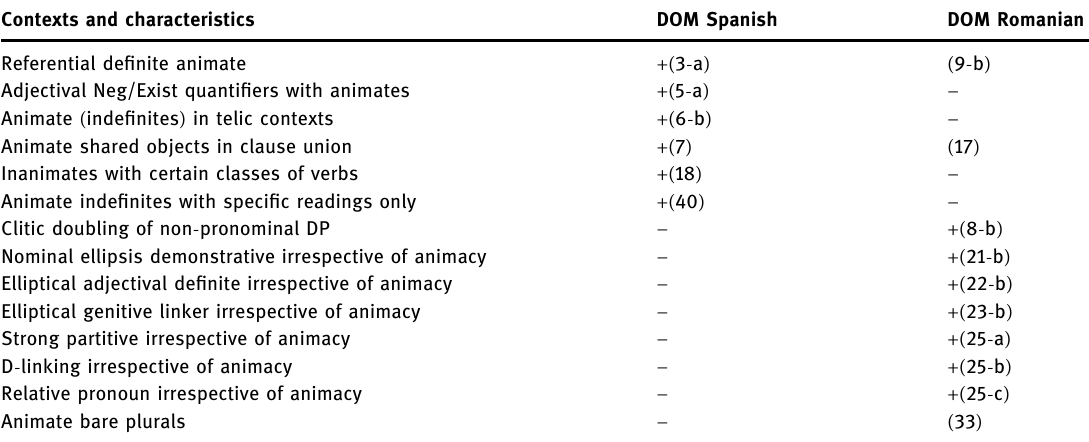
Table 12: Obligatory DOM: points of divergence – Spanish and Romanian Contexts and